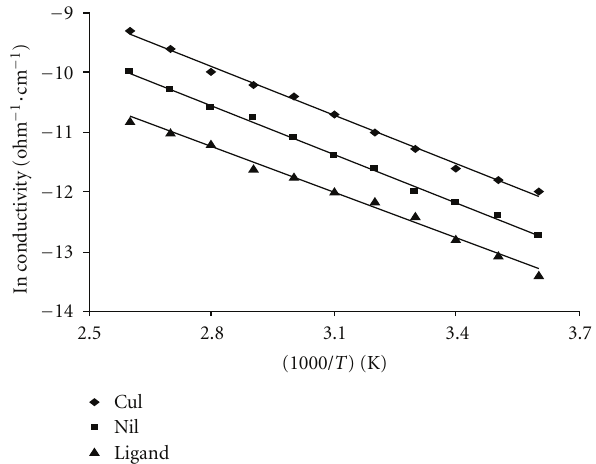
Figure 3: The DC conductivity of free ligand, Cu-complex, and Ni- complex after